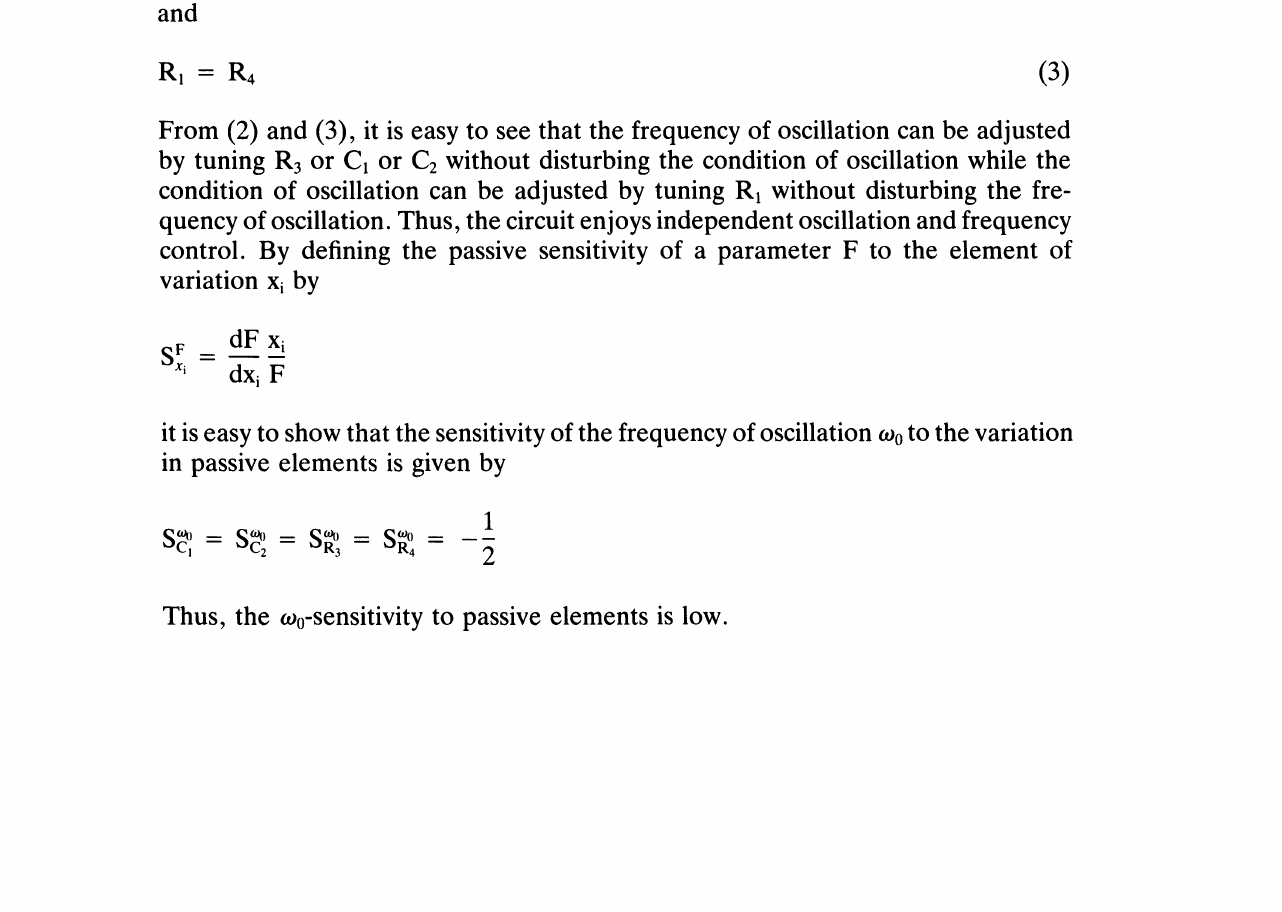
FIGURE Proposed oscillator